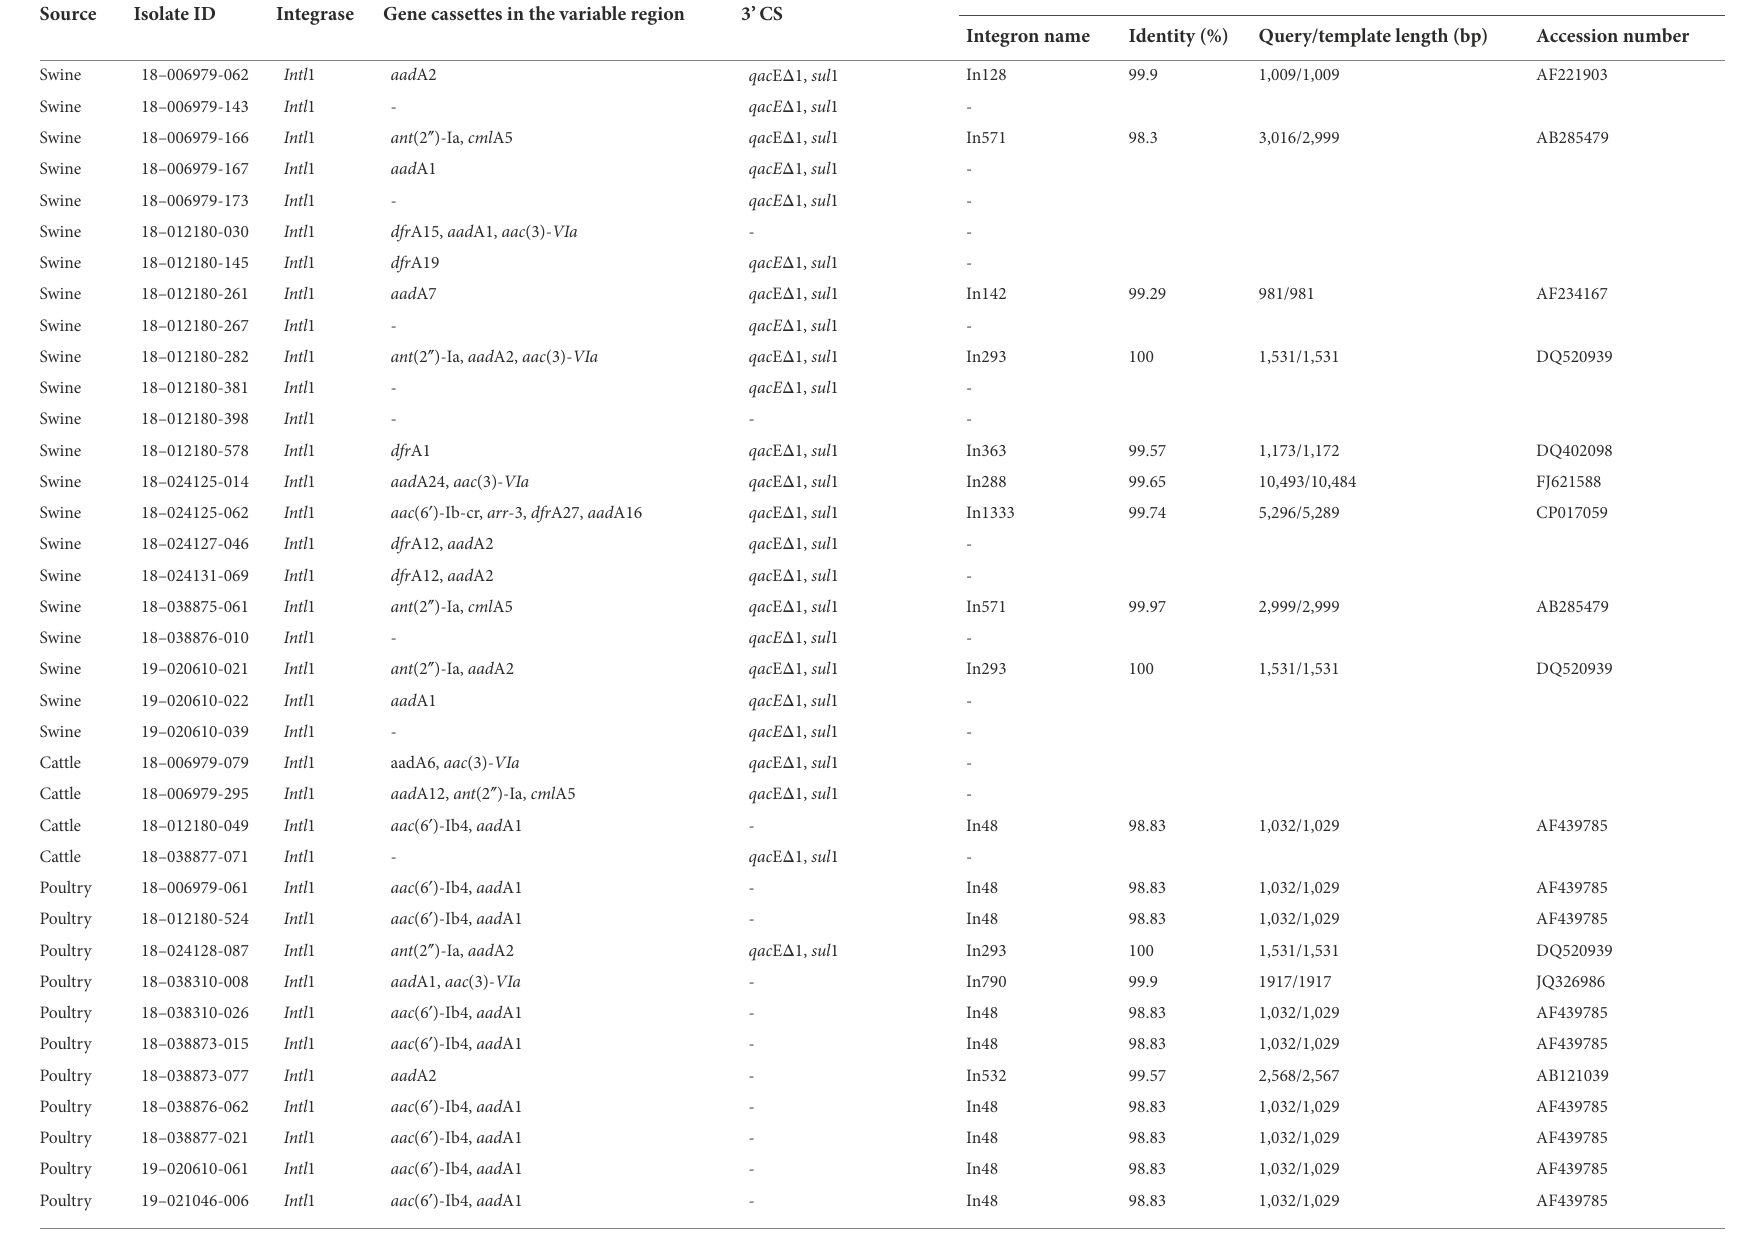
TABLE 2 Antimicrobial resistance genes detected in the variable region of class 1 integrons among Salmonella Senftenberg isolates from the